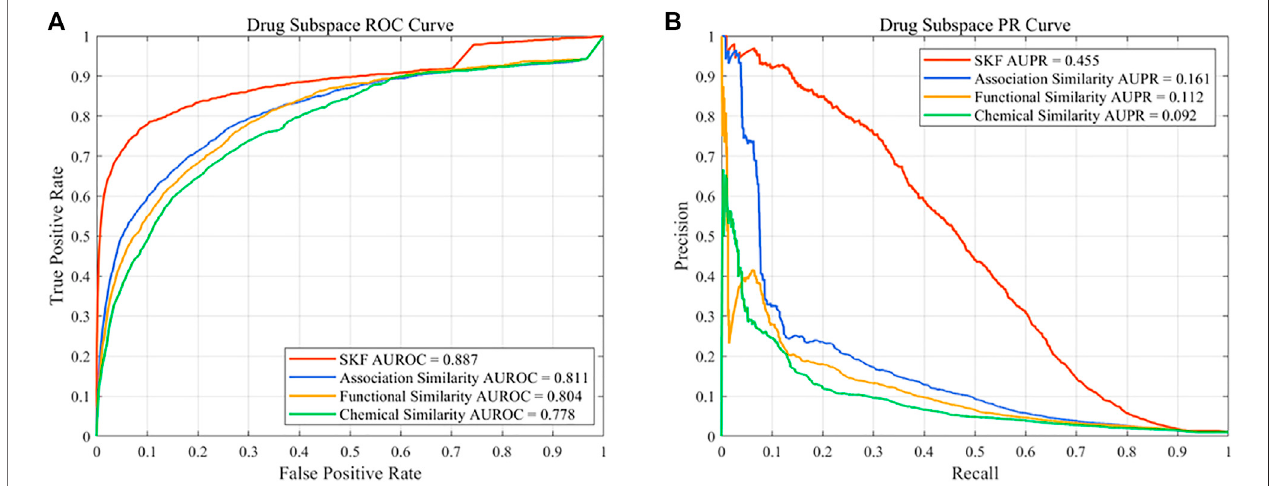
FIGURE 2 | Performance of the single similarity and SKF in the drug subspace of the PREDICT dataset. (A) ROC curve and (B) PR curve.